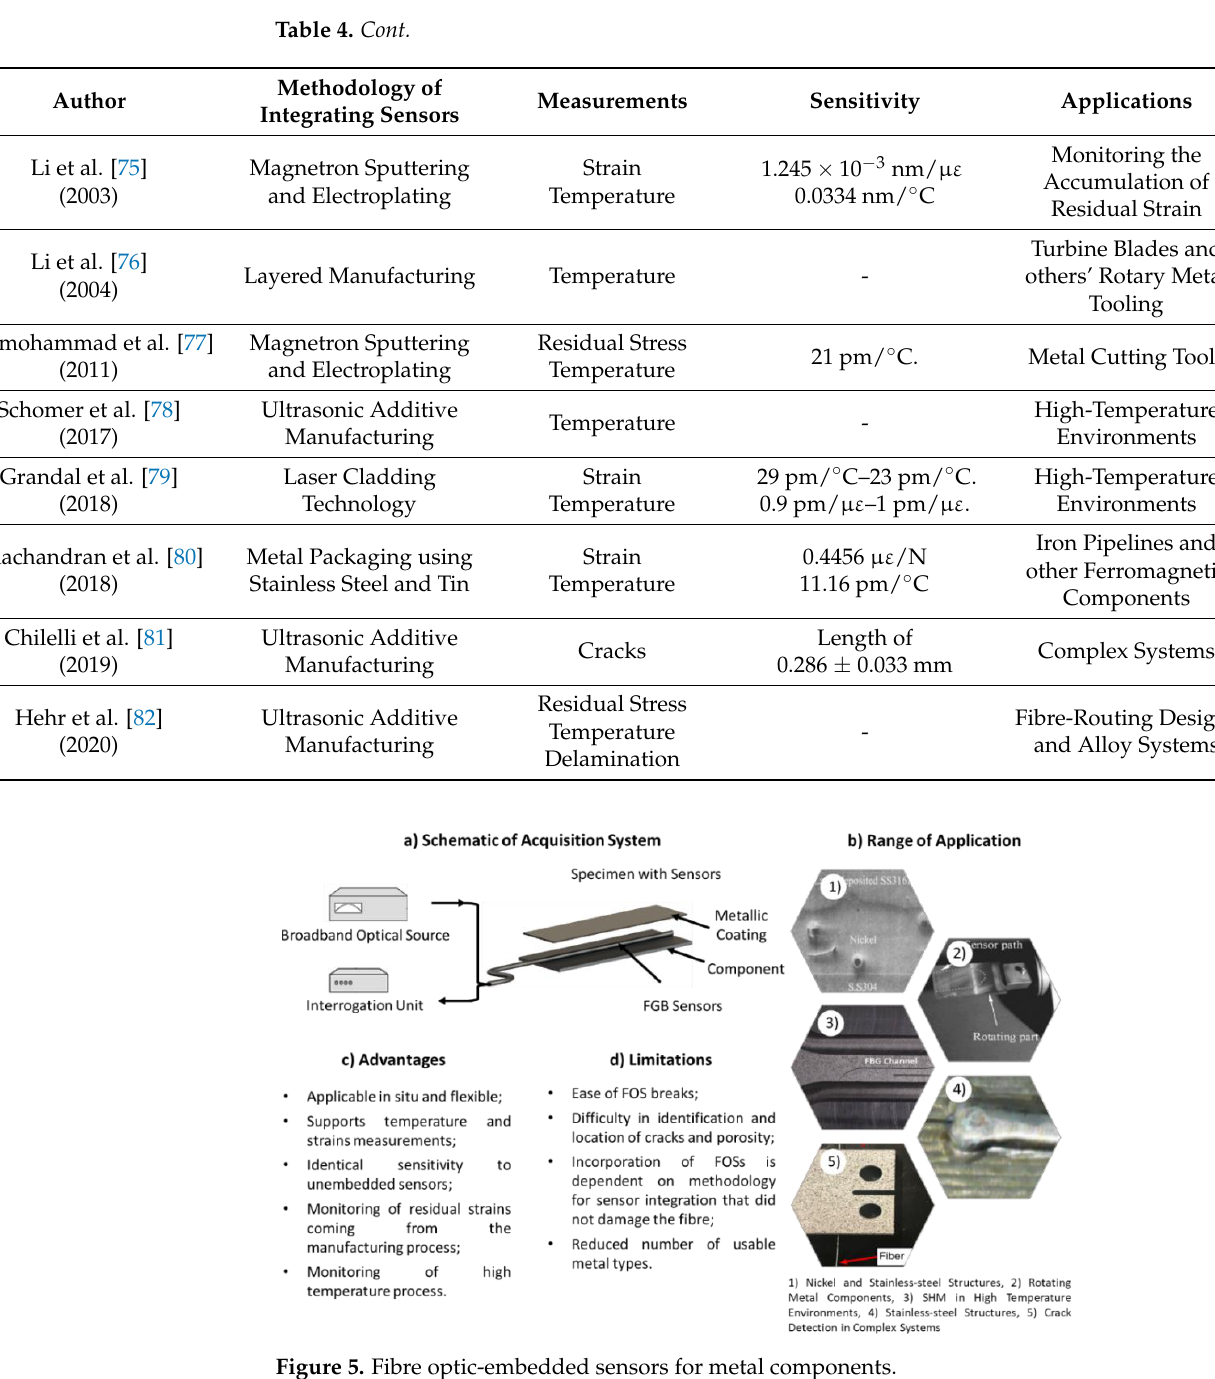
Figure 5. Fibre optic-embedded sensors for metal components.